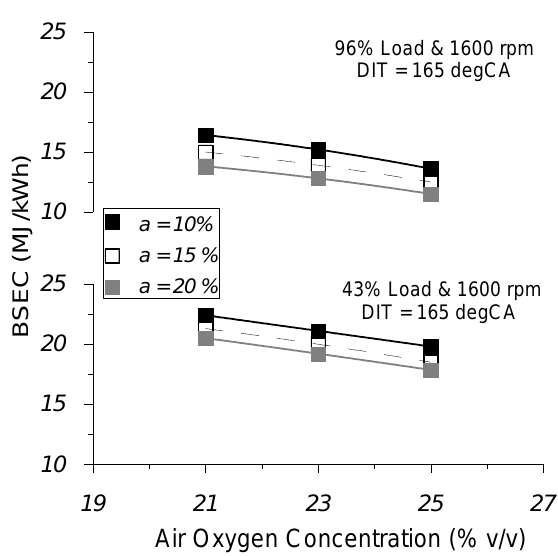
Figure 11. Calculated brake specific energy consumption versus “inlet-air oxygen ratio” for various “diesel fuel quantity ratios”, at 43% and 96% of engine rated load and 1600 rpm engine speed, for DIT = 165 degCA.